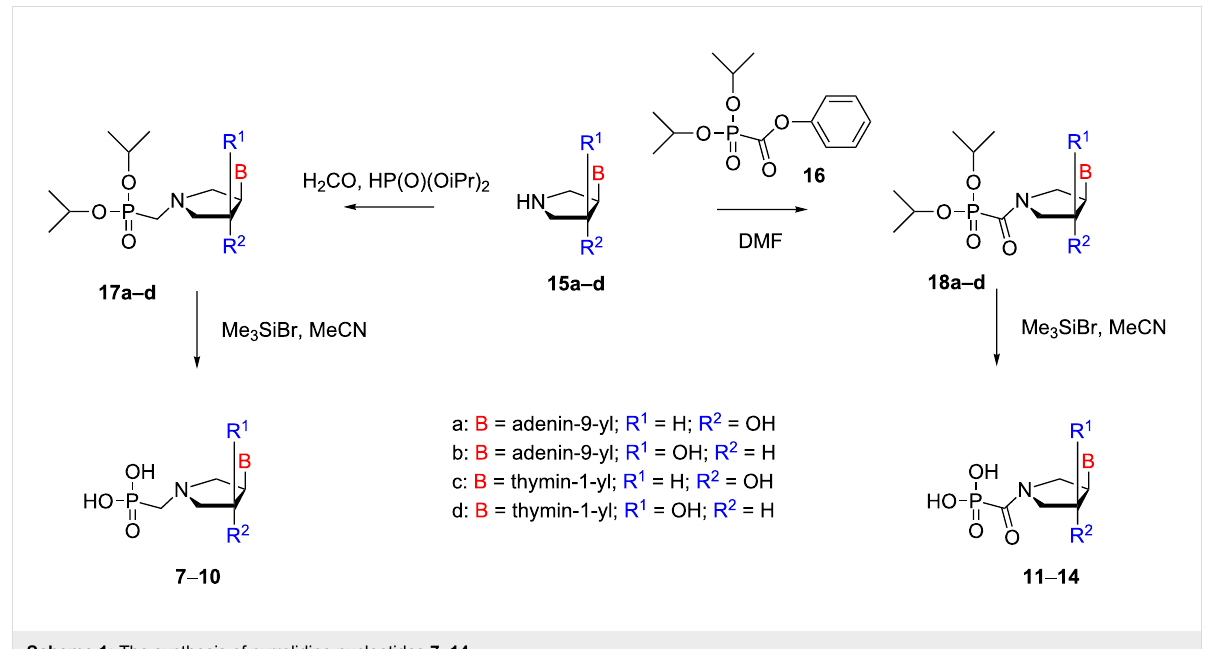
Scheme 1: The synthesis of pyrrolidine nucleotides 7 – 14